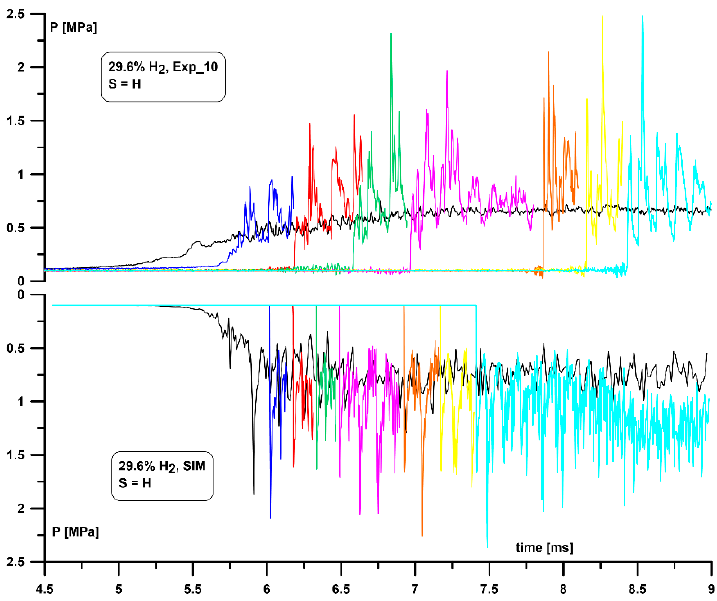
Figure 7. Experimental (top) and numerical (bottom) pressure profiles with detonation for case S = H and 29.6% H 2 in air. Sequence of sensors activation corresponds to the sensors position as in Figure 1. Same colors apply to sensors in the same position. Simulation time shifted +4.3 ms for better visibility.